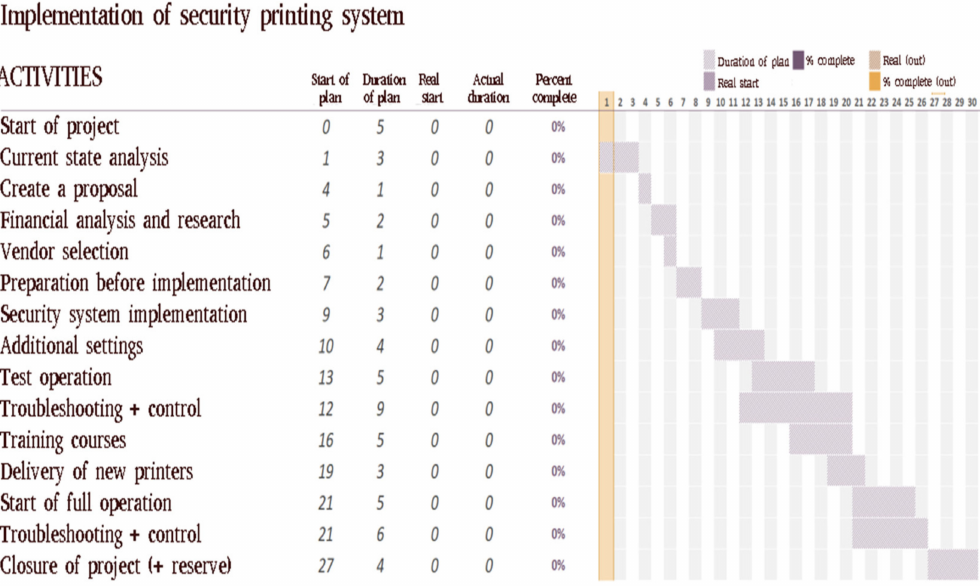
Figure 2. Gantt Chart of the original planned project timetable. Source: custom